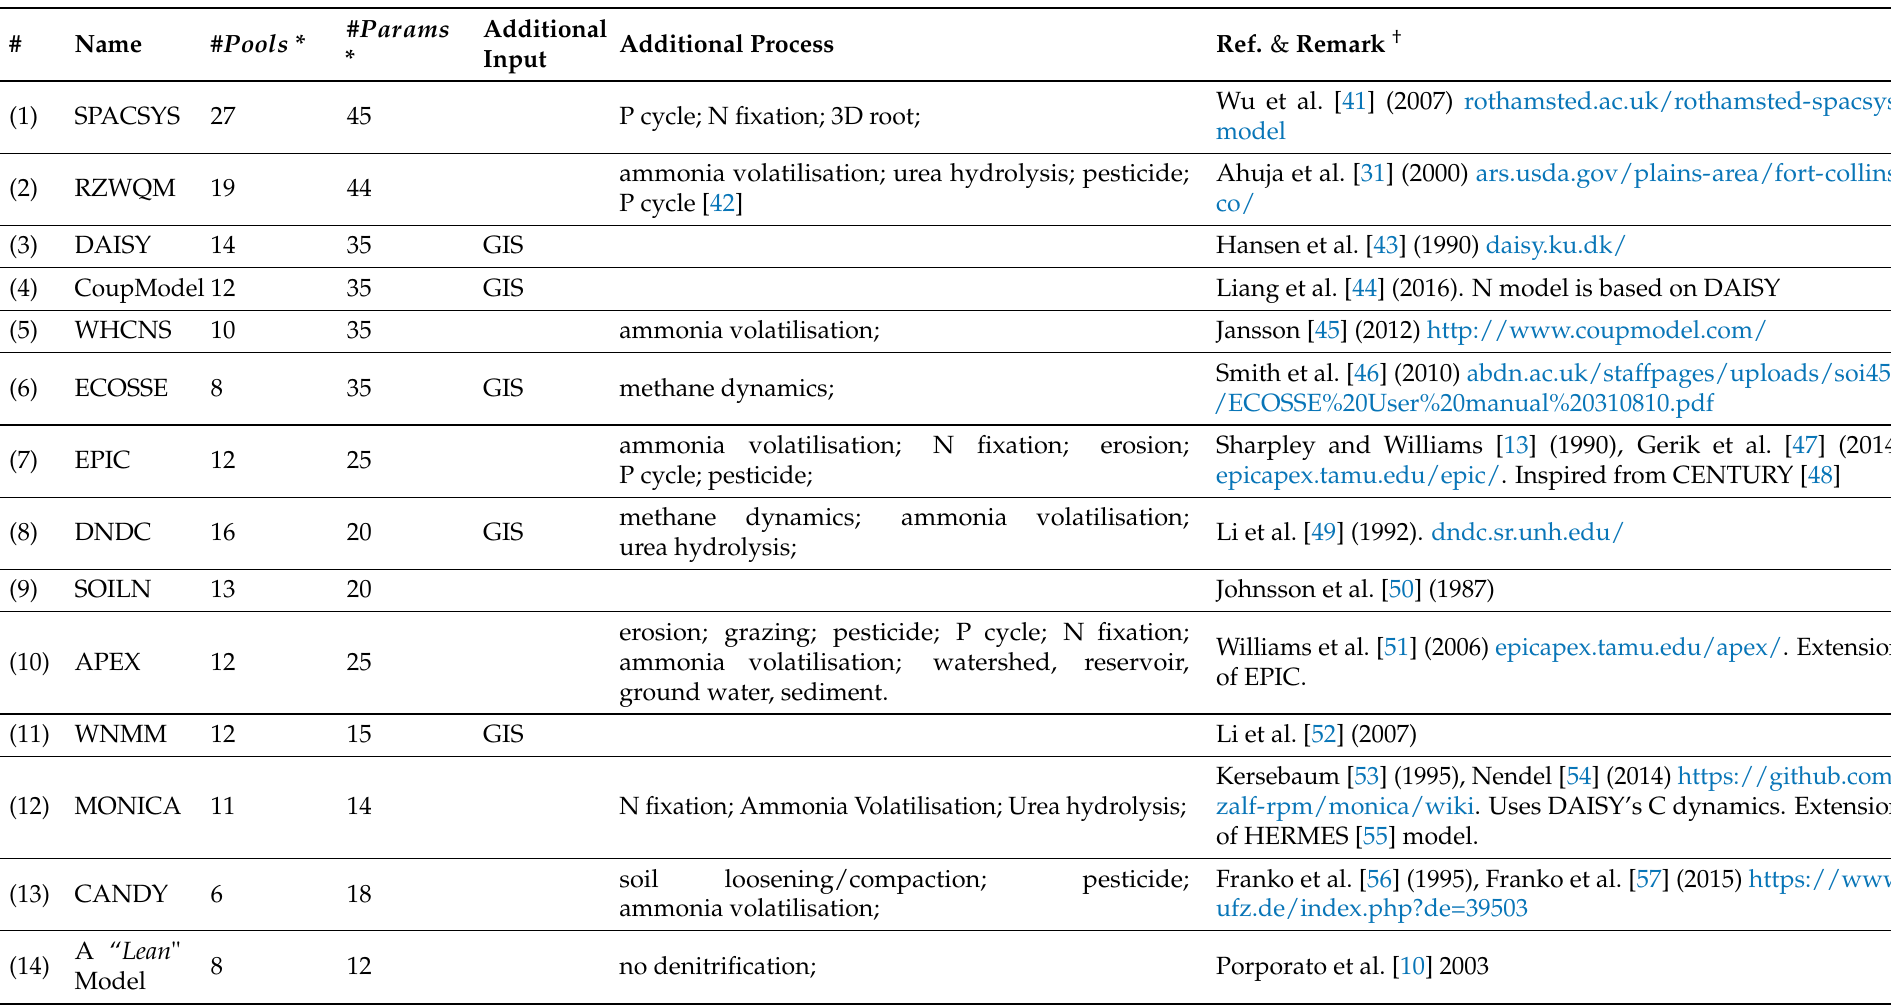
Table 1. List of soil Nitrogen (N) models ordered according to decreasing